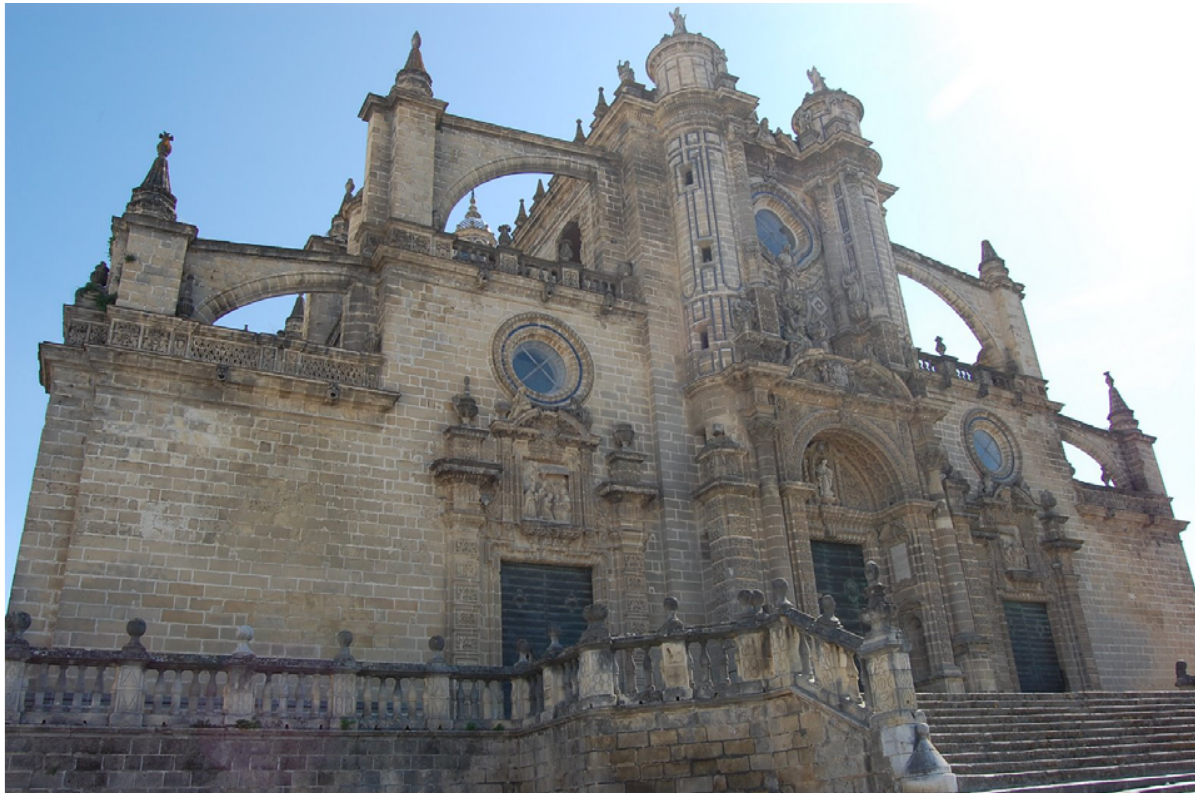
Figure 15: Exterior of the Cathedral of Jeréz de la Frontera. Image from http://www.fmschmitt.com/travels/spain/